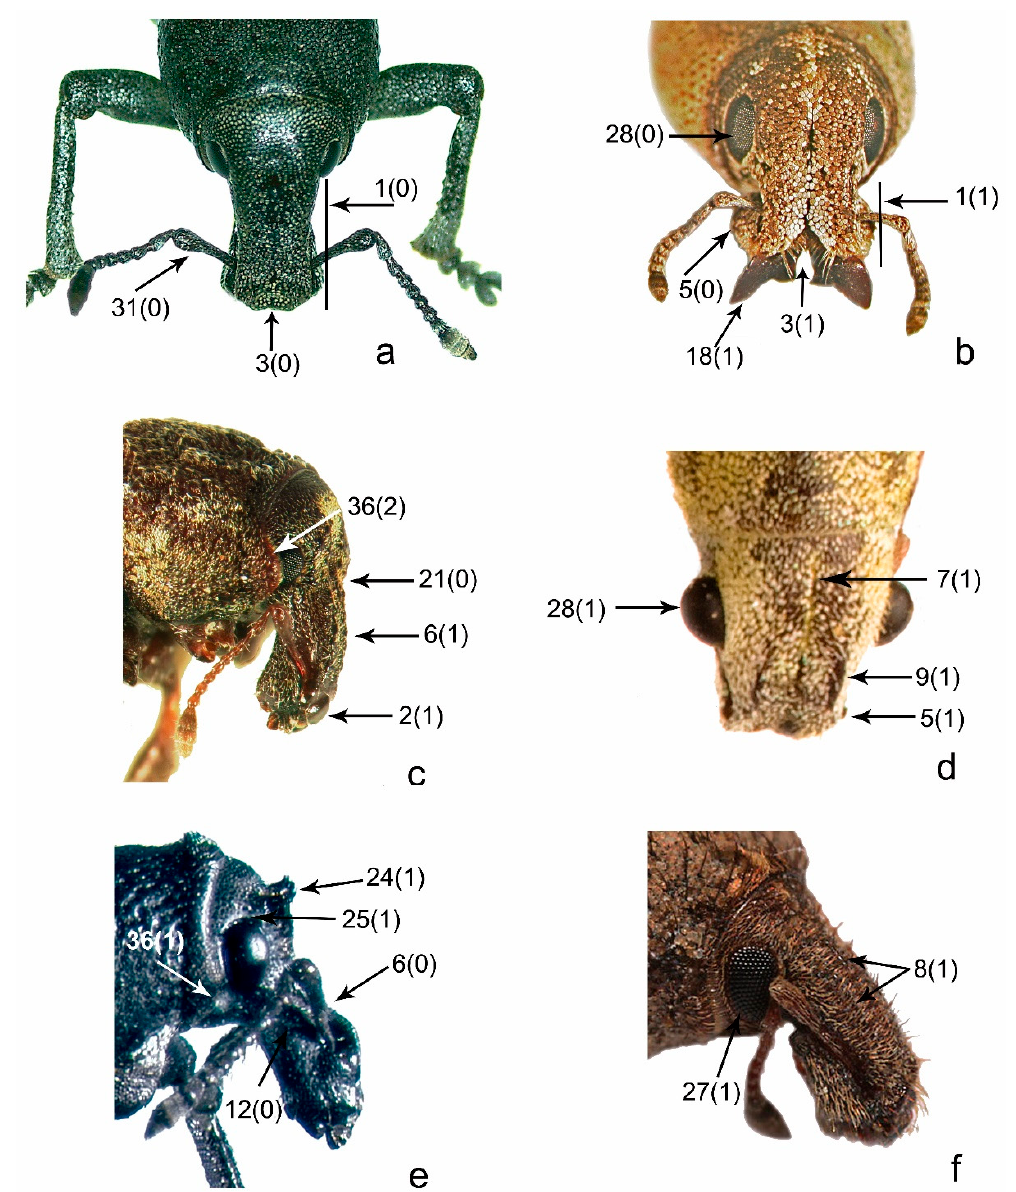
Figure 1. Morphology of adults, head and rostrum: ( a ) Strangaliodes niger , frontal view; ( b ) Pororhynchus labeonis , frontal view; ( c ) Premnotrypes latithorax , lateral view; ( d ) Hoplopactus lateralis , frontal view; ( e ) Aegorhinus vitulus , lateral view; and ( f ) Listroderes costirostris , lateral view. Arrows indicate characters and character states (between parentheses).